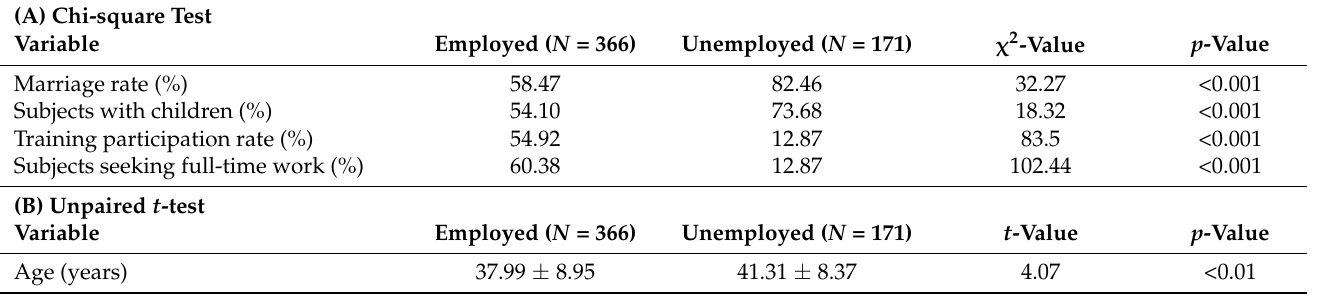
Table 3. Difference between unemployed and employed respondents along with the five indicators.